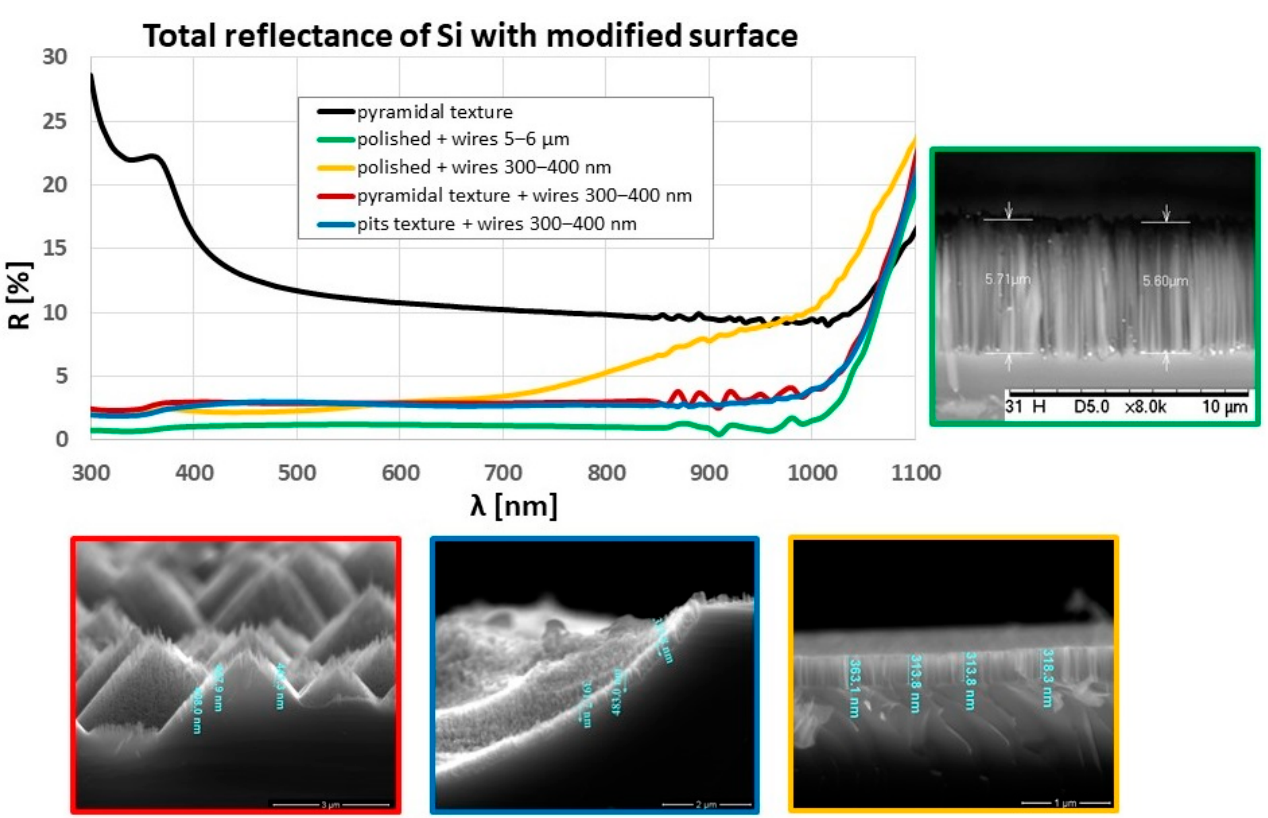
Figure 3. Total reflectance spectra of the silicon wafer with wires etched in MAE in the Si solar cell operating wavelength range of 300–1100 nm. Table 1. The average wire height in relation to the etching time